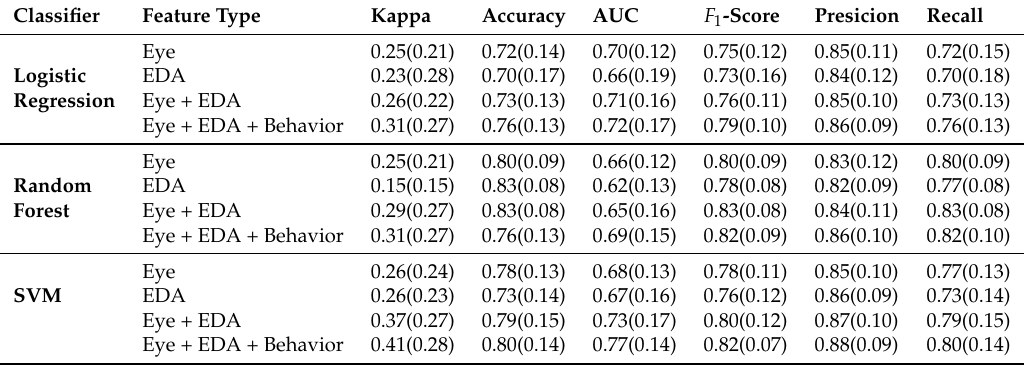
Table 4. In this table we report the results for different classifiers and feature sets. The numbers are reported in percentages. As seen in the table, all random forest-based classifiers achieved the highest F 1 -Score. The combination of Eye and EDA Features achieved the highest classification